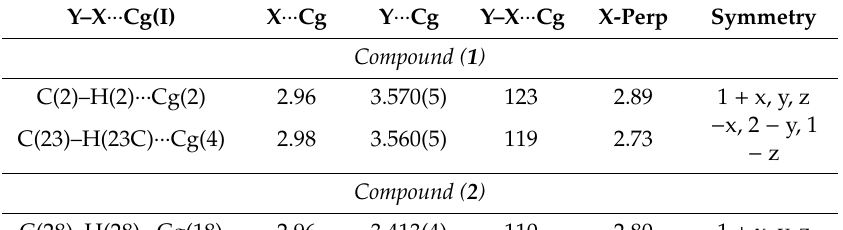
Table 4. Geometrical parameters (Å, ◦ ) for C–H ··· π interactions.